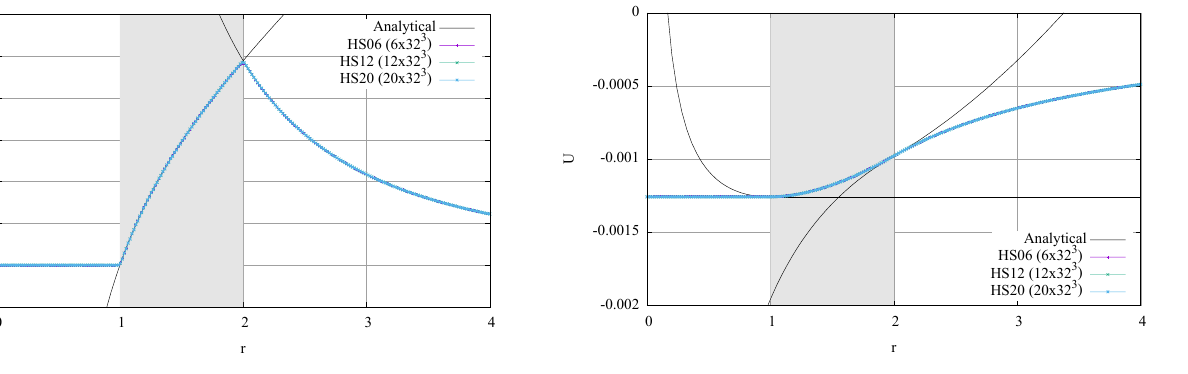
Figure 8. Norm of the gravity vector | g | as a function of the radial coordinate r . The gray area symbolises the spherical shell.